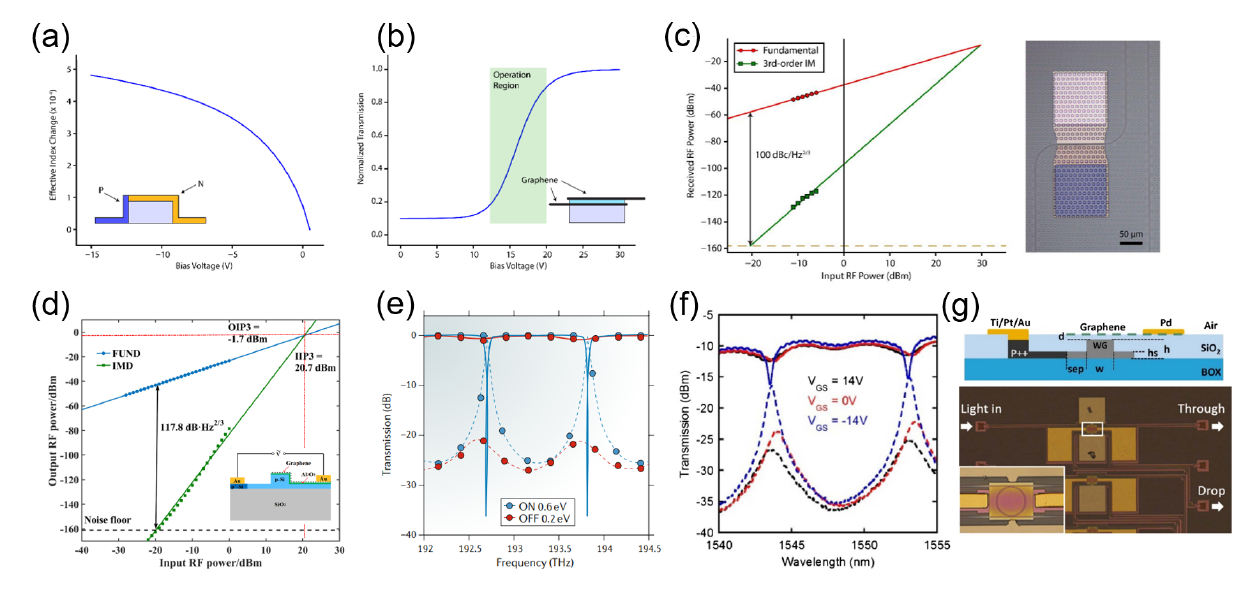
Figure 8. Characterizations of graphene-based EO modulators towards MWP applications. ( a ) TCAD simulation for a silicon PN junction modulator. Inset: doping cross-section of the simulated mod- ulator [76]. Reproduced from Ref. [76] with permission. ( b ) Calculated transmission versus bias voltage for a graphene EA modulator. Inset: modulator cross-section applying GOG capacitor [76]. ( c ) Two-tone (centered at 2.5 GHz) intermodulation response of the GOG EA modulator based on Si 3 N 4 waveguide. Inset: optical microscope image of the tested device [76]. ( d ) Calculated maximal SFDR for IMD3 obtained for the SLG EA modulator based on Si with an optimized insulation layer. Inset: schematic of the graphene EA modulator [77]. Reproduced from Ref. [77] with permission. ( e ) Calculated transmission spectra as a function of frequency for a Si micro-ring resonator in the ON (minimum micro-ring resonator absorption at E f = 0.6 eV) and OFF states (maximum micro-ring resonator absorption) [79]. Reproduced from Ref. [79] with permission. ( f ) Experimental through (solid lines) and drop (dashed lines) transmission spectra of GOS MRR switch for different gate volt- age values. ( g ) Cross-section of the GOS waveguide and the optical micrograph picture of fabricated devices [80]. Reproduced from Ref. [80] with